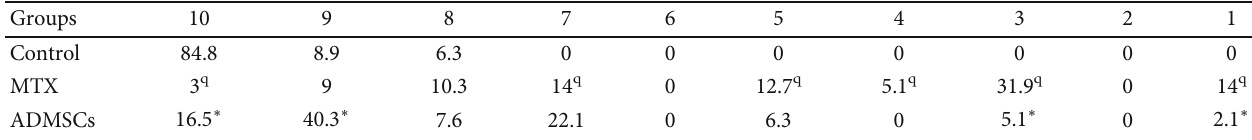
Figure 1: Expression of markers by fl ow cytometry on transplanted ADMSCs. The ADMSCs showed signi fi cant expression of mesenchymal markers (a) CD29 and (b) CD105. (c) The cells showed negative expression for CD34. Table 2: Johnson scores among the three groups.